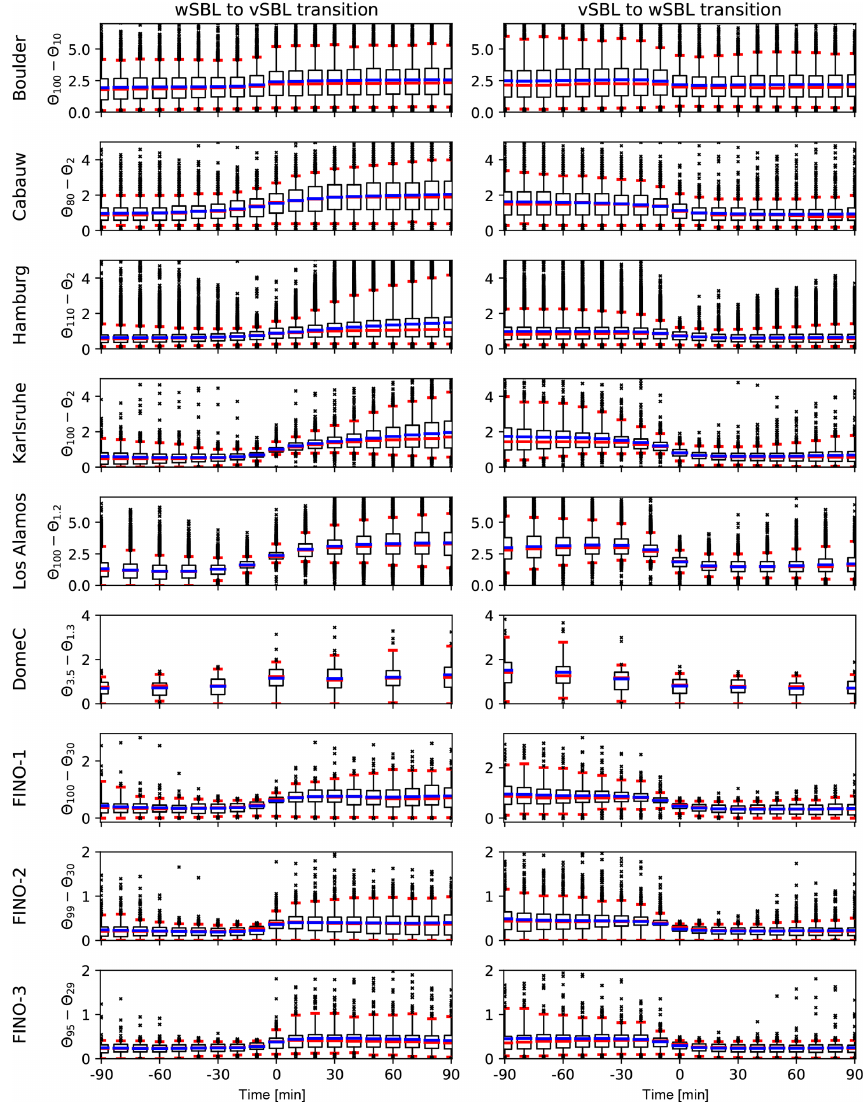
Figure 9. Time evolution of the distribution of the stratification as estimated by the potential temperature difference between about 100m and observations closest to the surface for land-based stations, between about 4 and 1m for DomeC and between about 100 and 30m for the sea-based stations in times of wSBL to vSBL (left) and vSBL to wSBL transitions (right). The distributions show the interquartile range (box), 5th to 95th percentile range (outer red bars), median, and mean values (or red and blue